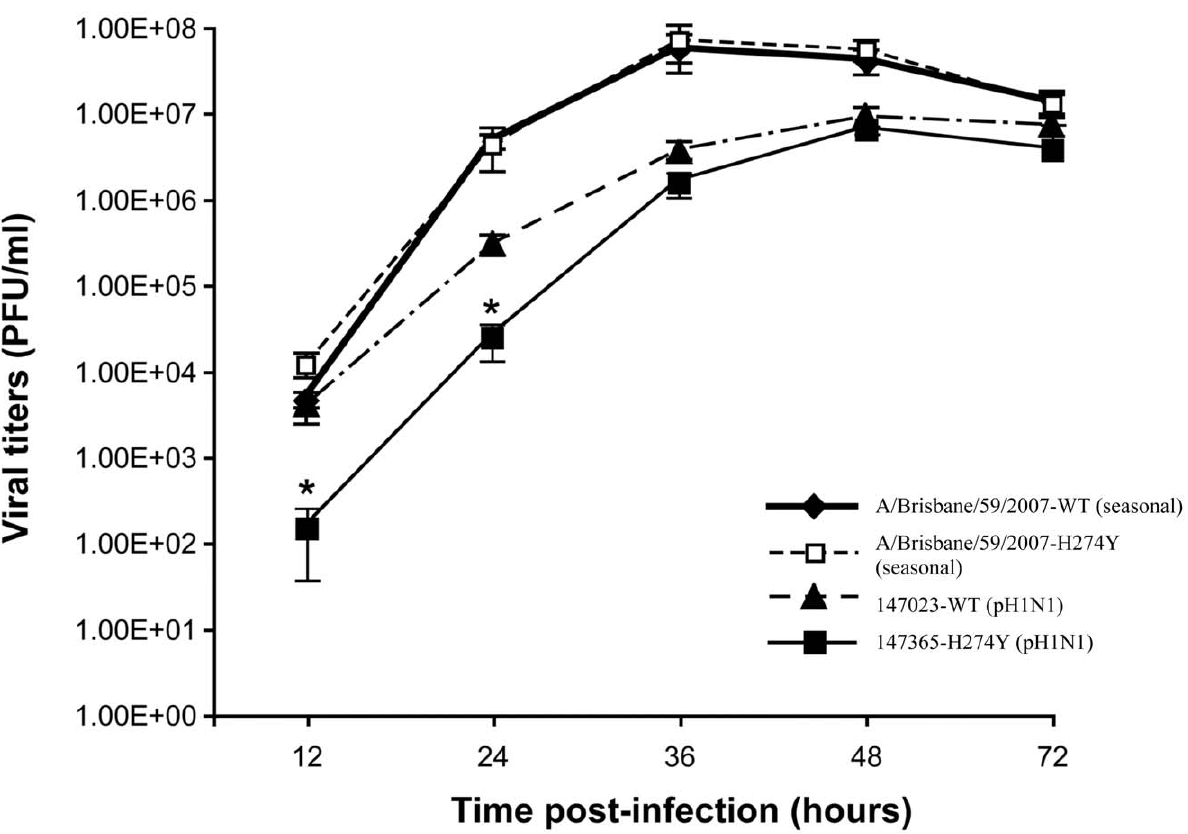
Figure 1. Replicative capacities of wild-type (WT) and H274Y mutant isolates of pH1N1 and seasonal A/H1N1 viruses. Viral titers were determined at the indicated time points from supernatants of ST6Gal I-expressing MDCK cells infected with pH1N1 A/Que´bec/147023/2009 (WT), pH1N1 A/Que´bec/147365/2009 (H274Y mutant), A/Brisbane/59/07-like (WT) and A/Brisbane/59/07-like (H274Y mutant) isolates at a multiplicity of infection (MOI) of 0.001. Mean viral titers 6 SD from triplicate experiments were determined by using standard plaque assays. * P , 0.05 between the WT and H274Y pH1N1 viral titers.